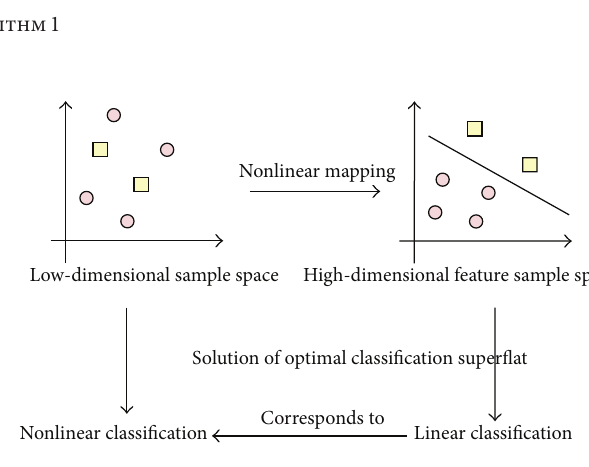
Figure 4: Principles of support vector machine